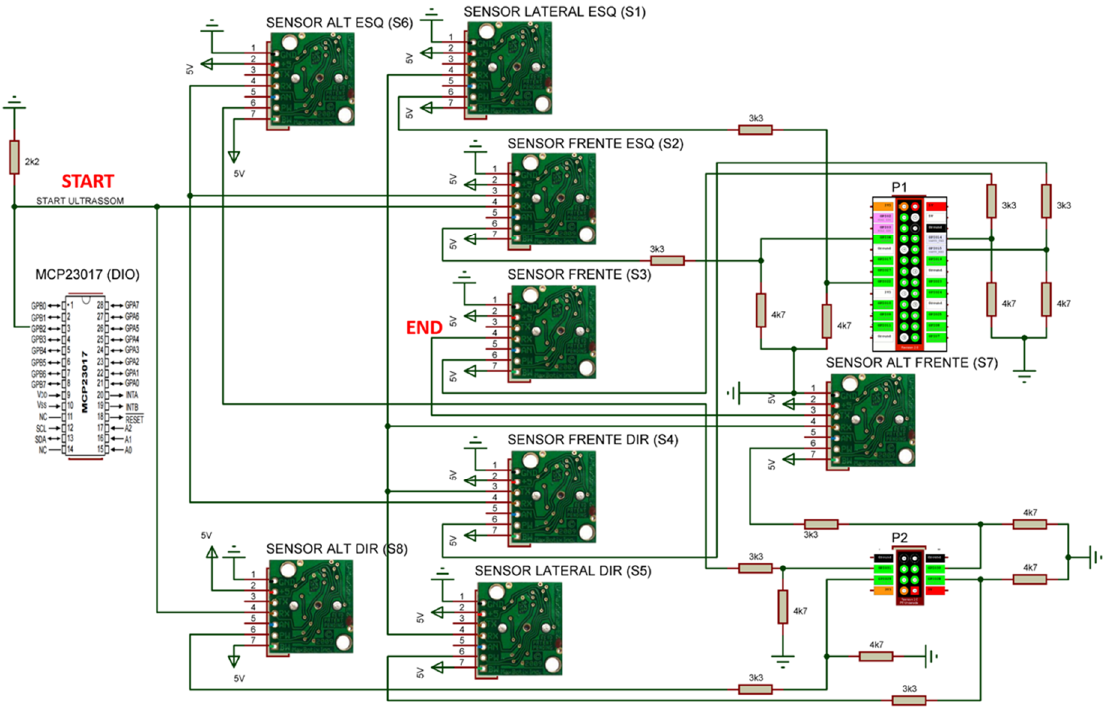
Figure 9. Interconnection diagram of ultrasound sensors.